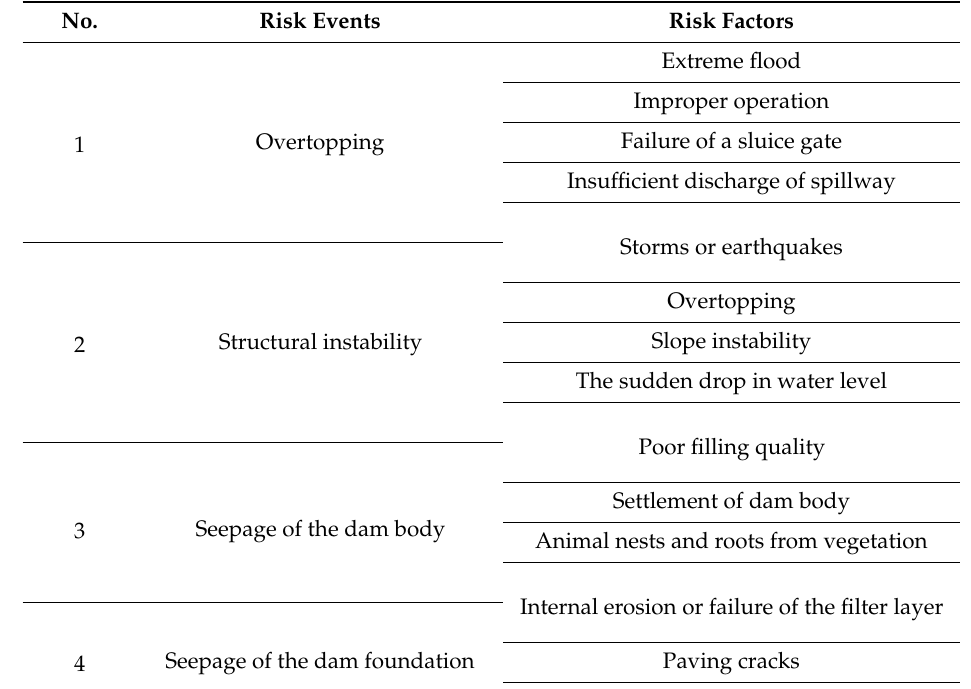
Table 1. Major risk factors of the earth-rock dam